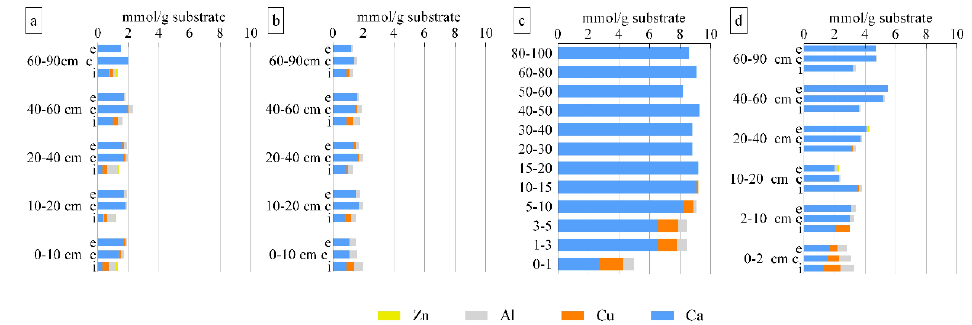
Figure 5. Chemical composition of the solid samples versus height in reactors: ( a ) A-SDES; ( b ) B-SDES; ( c ) C-DAS; ( d ) D-ADES. In DES reactors (A, B, and C) “i” stands for the inner annular section (0–1.5 cm) next to the screen, “m” for the middle annular section (1.5–3.5 cm), and “e” for the outer or exterior annular section (3.5–6.5 cm).